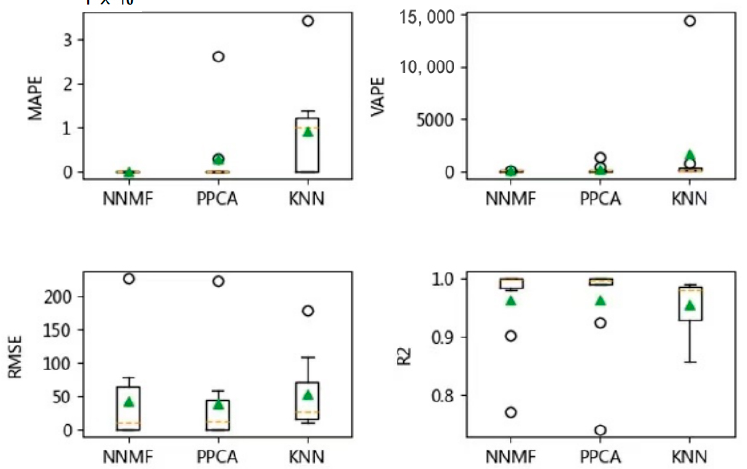
Figure 14. Evaluation results of the data imputation by NNMF, PPCA and KNN for vehicle of ***Y278 under the missing rate of 0.6.